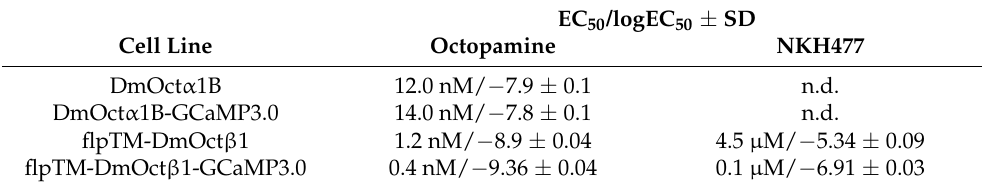
Table 1. EC 50 values of DmOct α 1B and FlpTM-DmOct β 1 cell lines for octopamine and NKH477. EC 50 values of DmOct α 1B and FlpTM-DmOct β 1 cell lines for octopamine and NKH477 were determined with Fluo-4 and GCaMP3.0. Measurements with flpTM-DmOct β 1 cell lines were performed in the presence of 100 µ M IBMX. EC 50 values are from a typical experiment with eight-fold determinations for each data